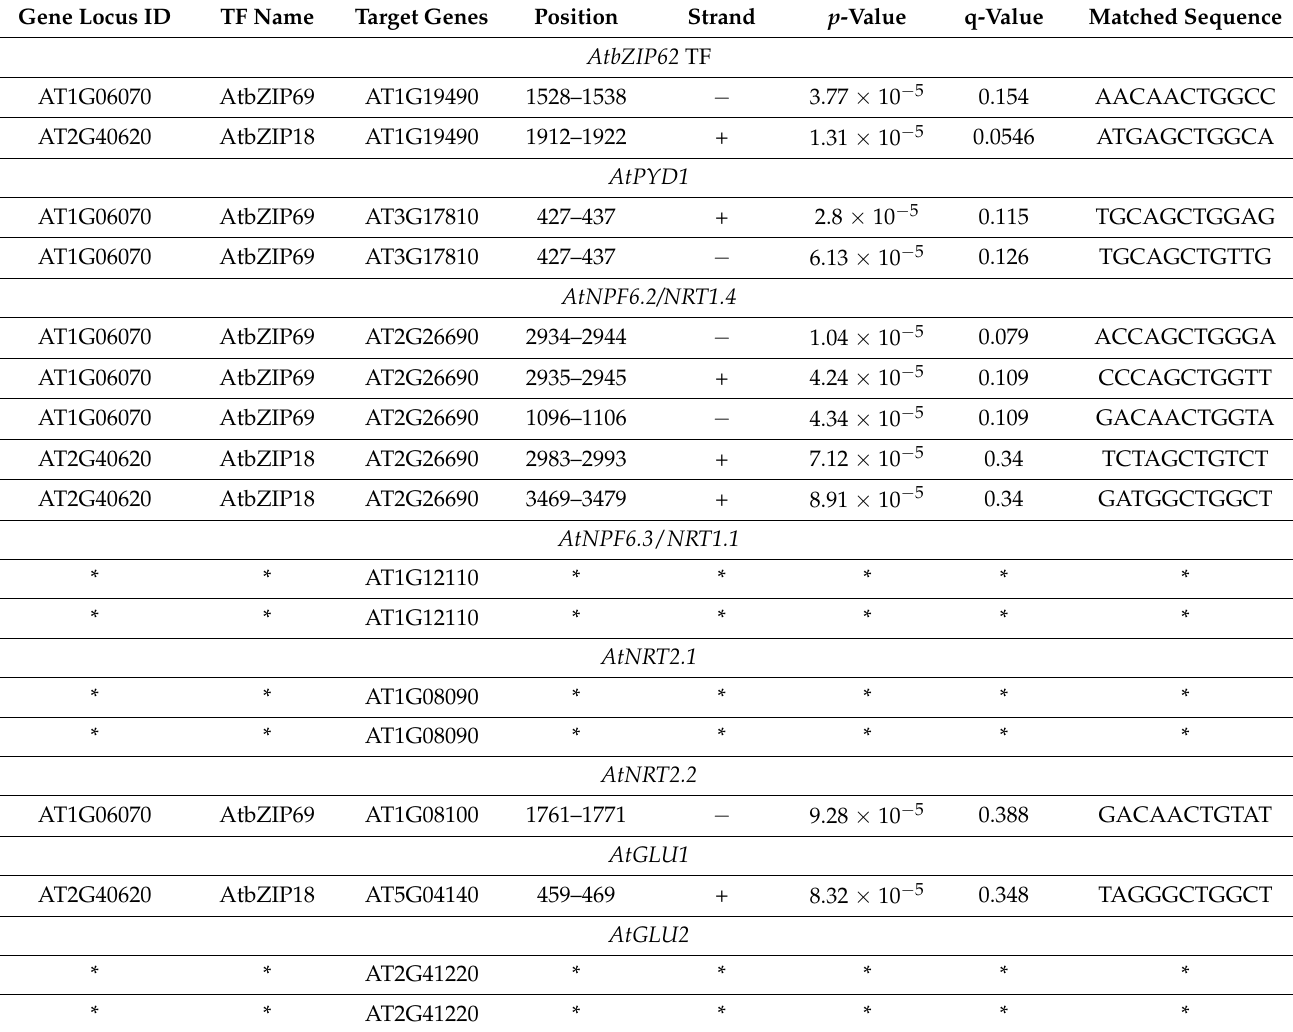
Table 1. Identified transcription factor binding sites in the promoter of target genes. Gene Locus